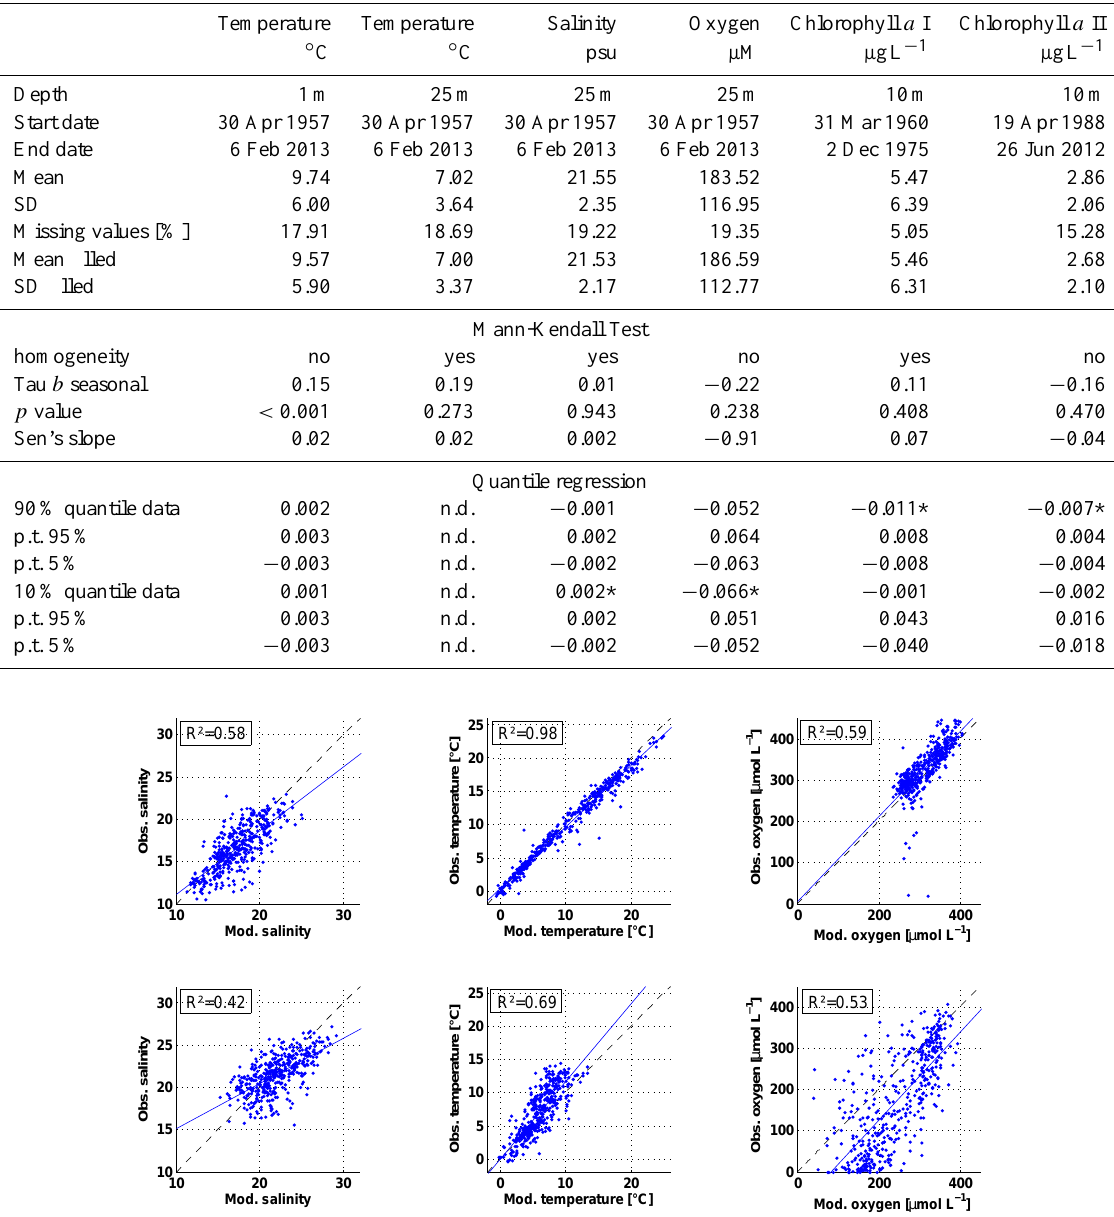
Table 4. Descriptive and test statistics for Mann–Kendall test (MKT) and quantile regression. SD: standard deviation; filled: time series after gap filling described in Sect. 2.2; Tau b : Kendall coefficient for time series including ties; Sen’s slope: median slope present in time series (yr − 1 ); p.t.: pooled trends with bootstrapping of 500 generated time series described in Sect. 2.2. * denotes significance on the 0.1 level for quantile regression.